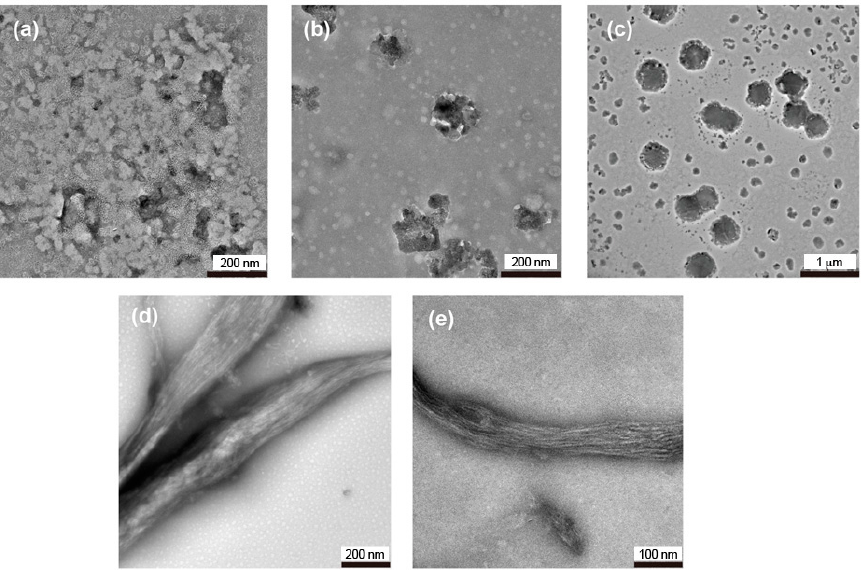
Figure 3. TEM images of 2Np-CMP n ( n = 3–7) assemblies formed in water (5% TFE) at 4 °C ( n = 3 ( a ), n = 4 ( b ), n = 5 ( c ), n = 6 ( d ), n = 7 ( e )). [2Np-CMP n ] = 60 μ M. The images were obtained by stain- n = 4 ( b ), n = 5 ( c ), n = 6 ( d ), n = 7 ( e )). [2Np-CMP n ] = 60 µ M. The images were obtained by staining ing with 1% phosphotungstic acid. with 1% phosphotungstic